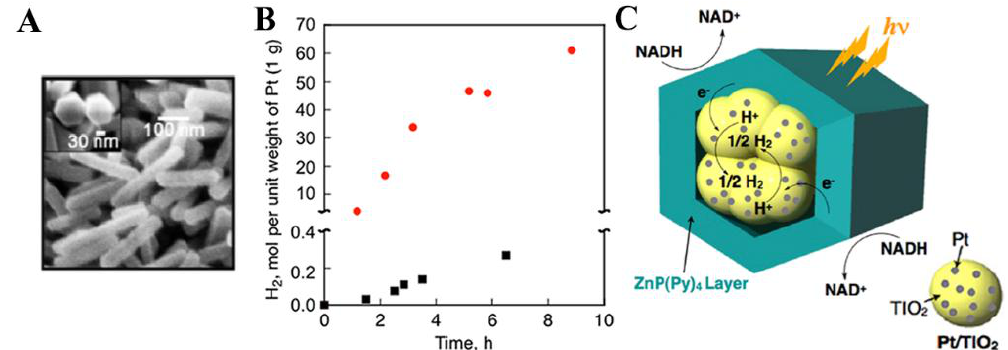
Figure 6. ( A ) SEM image of Pt/TiO 2 -ZnP(Py) 4 nanorods; ( B ) Time dependence of hydrogen evolution: (●) Pt/TiO 2 -ZnP(Py) 4 rods, ( ■ ) non-encapsulated Pt/TiO 2 + ZnP(Py) 4 composites. ( C ) A schematic illustration for photocatalytic hydrogen evolution. Reprinted with permission from [75]. Copyright 2013, American Chemical Society.